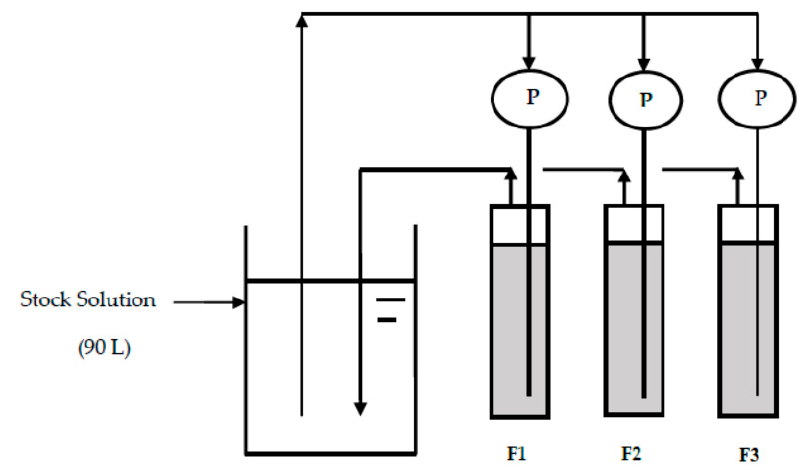
Figure 1. Schematic diagram of the fluoride removal setup.